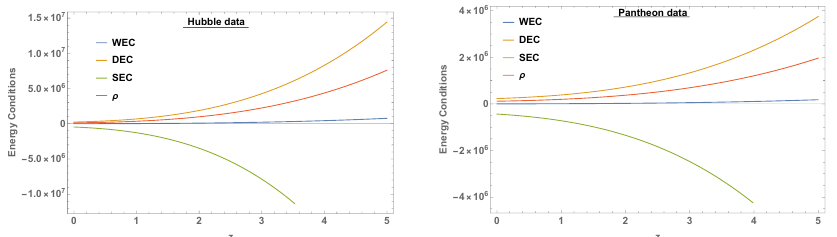
Figure 7. The behavior of energy conditions against the redshift parameter z with the constraint values of the coefficients in (29) λ = 2, m = − 5, n = 1.05 for f ( Q ) = Q + mQ n .